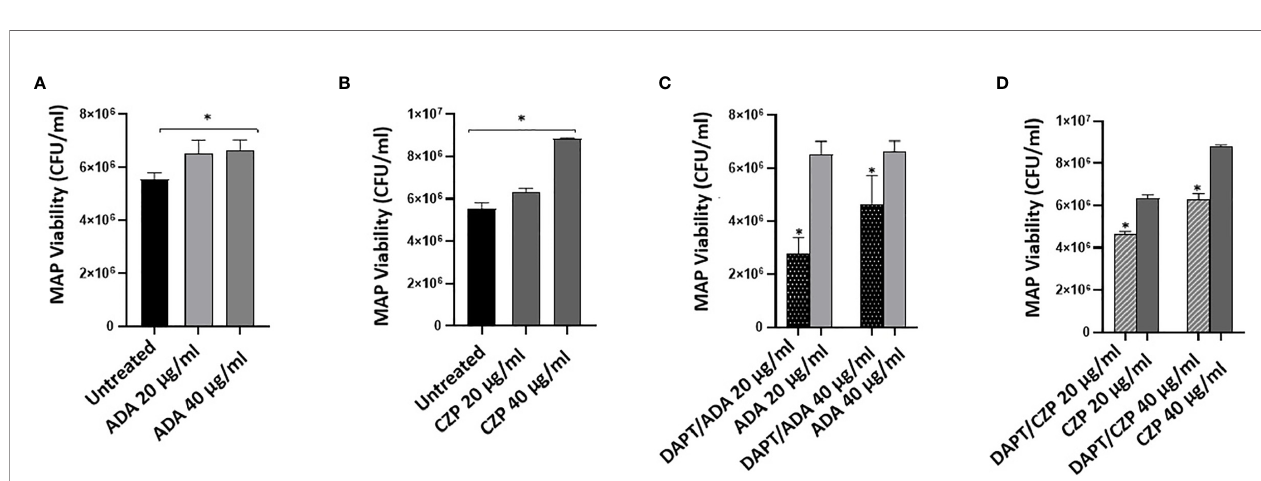
FIGURE 2 | Anti-TNF- a agents potentiate Notch-1 and its downstream effect on IL-6 and MCL-1 expression in MAP infected macrophages. MAP infected-THP-1 derived macrophages were treated with non-PEGylated (ADA) and PEGylated (CZP) anti-TNF- a agents (0-40 m g/ml). The expression level of (A) Notch-1, (B) IL-6, and (C) MCL-1 were detected by RT-PCR. All experiments were performed in triplets. Data are shown as mean ± SD, and signi fi cance is considered as *P < 0.05.